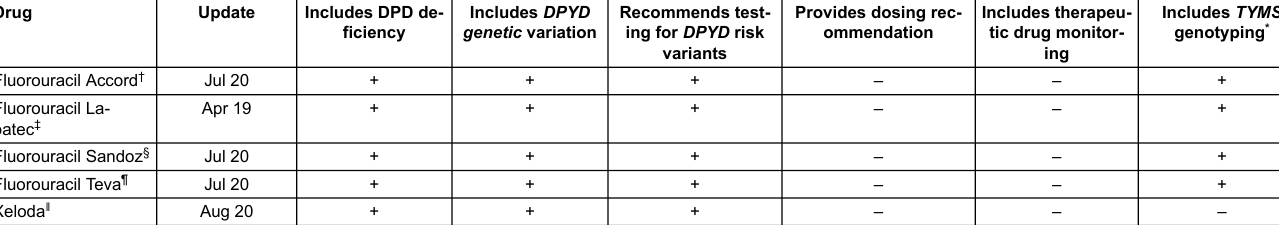
Table 1: Overview of information on fluoropyrimidine pharmacogenetics and therapeutic drug monitoring in Swiss 5-fluorouracil and capecitabine drug labels. Drug